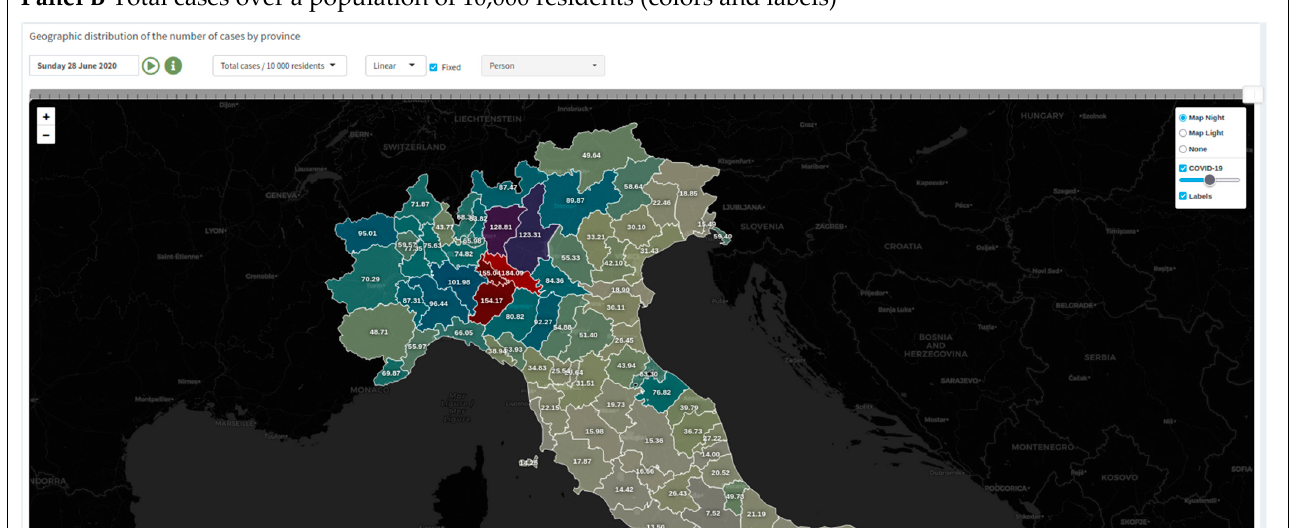
Figure 6. Map section of the COVID-19 website app. The map shows regional or provincial tessel- lation for the nation. Each tile is colored proportionally to the intensity of the selected measure. The option to run a day-by-day animation of the progression of the chosen measure is also provided. Panel ( A ): Map representation with a color palette. Panel ( B ): Map representation with labels.